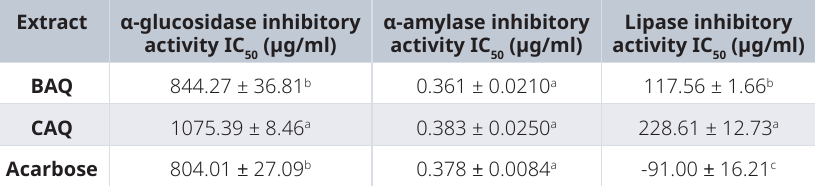
Values within the same column followed by different superscript are significantly different (p < 0.05).